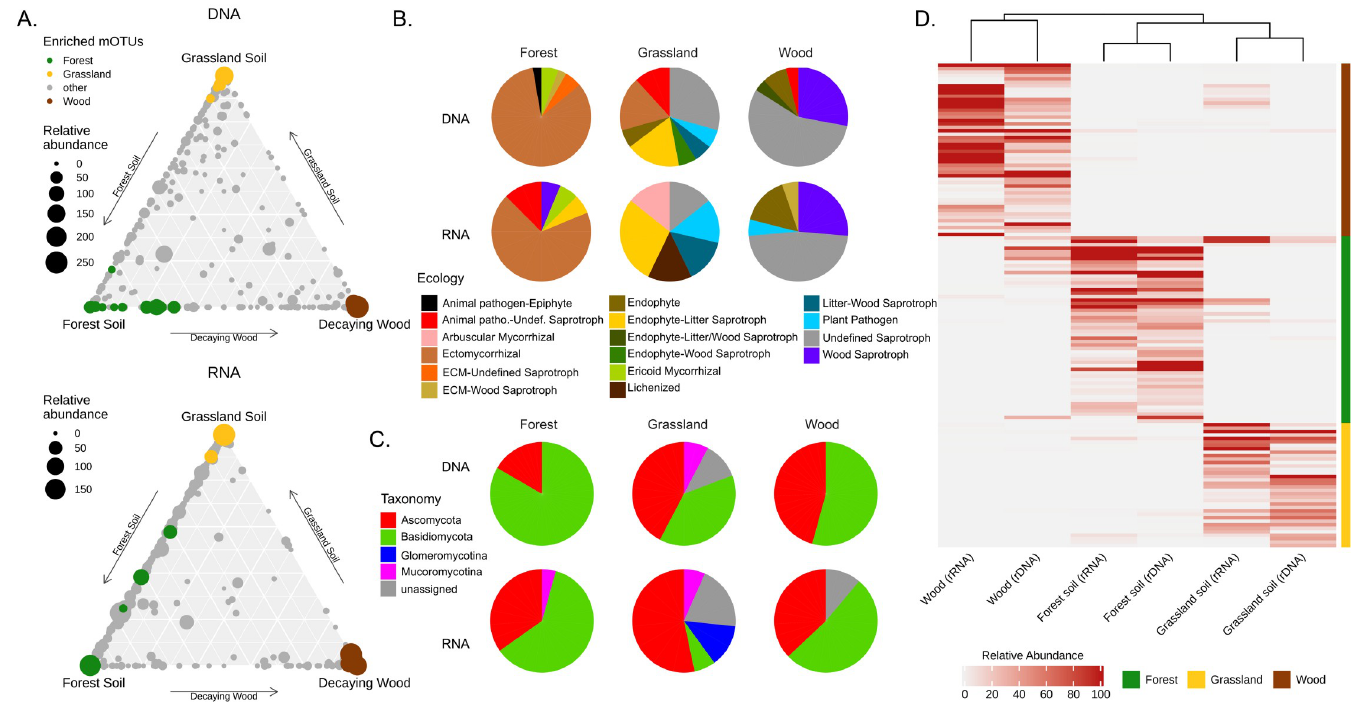
Fig 5. Differential abundance analysis. (A) Ternary plots illustrating the distribution of individual MOTUs (closed circles whose sizes reflect their abundance in terms or read numbers) in each of the three studied habitats. Plots were drawn separately for the DNA and RNA datasets to illustrate that the relative abundance of taxa in the three habitats varies depending on the nucleic acid used for metabarcoding. Taxa over-represented (following differential abundance analysis) in either forest soil, grassland soil or decaying wood are identified using a specific color code. (B) Pie charts that illustrate the taxonomic distribution (phylum level) and ecology (according to [Nguyen 2016 [66]]) of significantly over-represented MOTUs, identified at the species level, in each of the three habitats. (C) Mean relative abundance heatmap of enriched MOTUs in decaying wood (brown), forest soils (green) and grassland soils (yellow) across DNA and RNA samples from the different habitats. (D) Similarities between datasets was calculated using Spearman distances between samples and rows were clustered by MOTUs enriched in each habitat type. Displayed mean-relative abundance values were cut at 100 rarefied reads threshold.